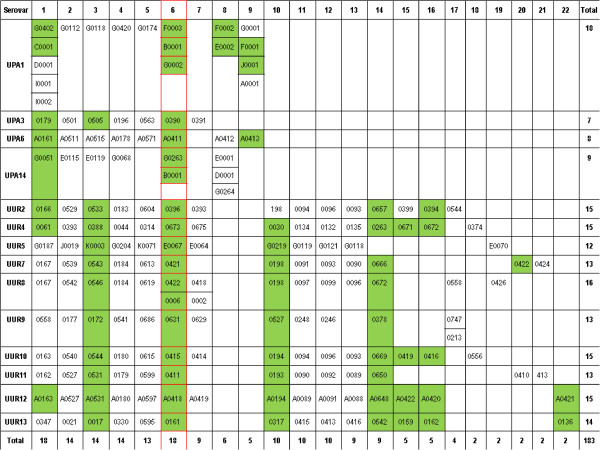
Clusters of Orthologous Genes Potentially Involved in the MBA Phase Variable System of Ureaplasmas.  This table contains the NCBI locus tags for genes potentially involved in the MBA phase variable system. To form the NCBI locus tag add the serovar id and underscore before the gene number: UPA1_G0402; UUR12_A0163. Genes with tandem repeats are highlighted in green. A red box is drawn around the 4MBA genes expressed in ATCC type strains.